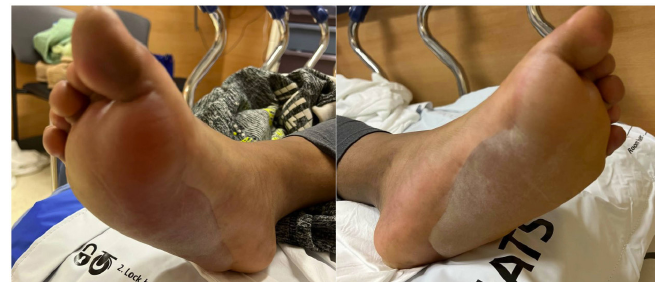
Image 1. Bilateral partial-thickness frostbite on patient 1 with a broken serous blister on the left.